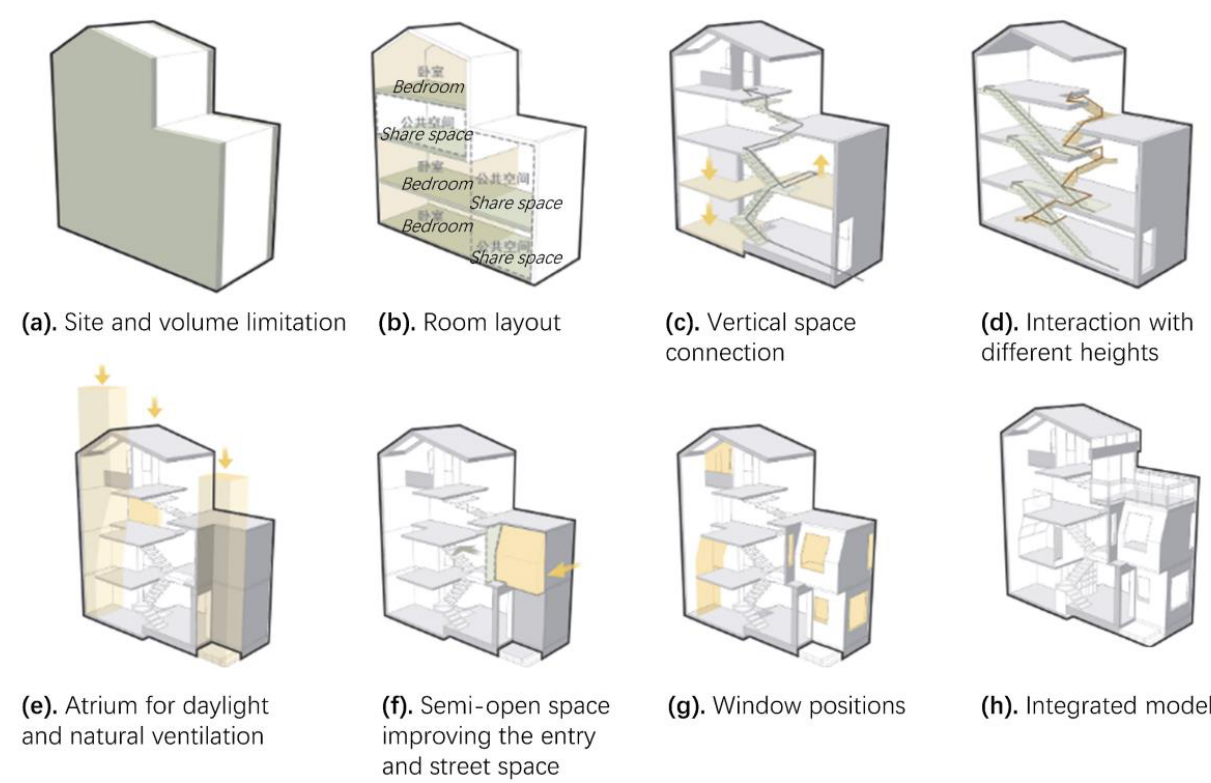
Figure 20. Design process diagram for one of the concept designs (drawn by the students).